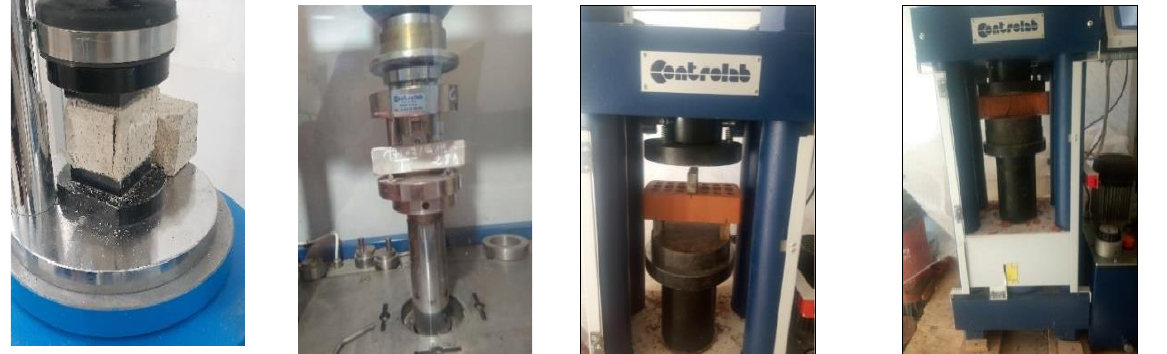
Figure 1. Three-point bending test and compressive test for mortar prisms and brick specimens (Compressive strength machine, Controlab, Saint Ouen L’Aumône,